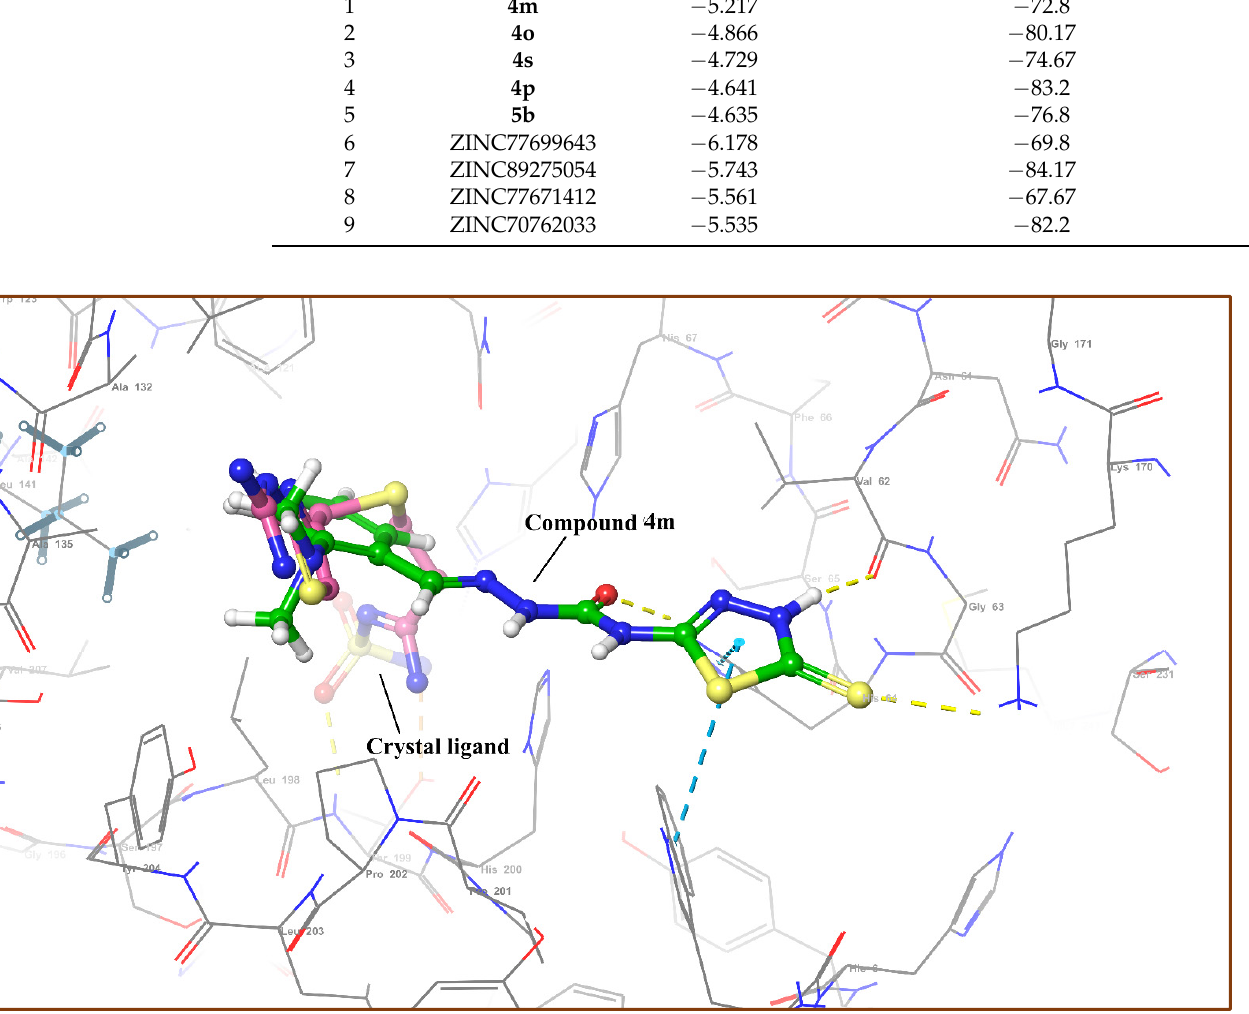
Figure 6. 3D interactions of compound 4m and crystal ligand with different amino acids His64, Val62 at the binding site of receptor 6g3v.